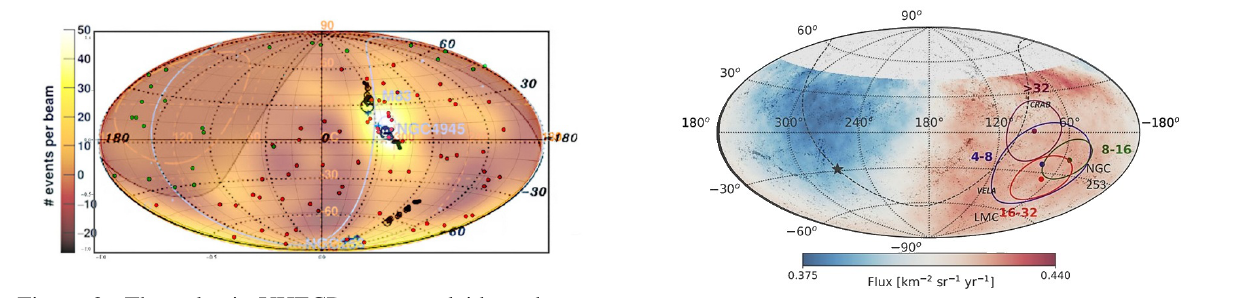
Figure 3: The UHECR dipole clustering in equatorial coordinates. Blue, green, red, and violet points and curves indicate di ff erent energy ranges (4-8, 8-16, 16-32 and > 32). Few suggested galactic or nearby extragalac- tic source candidate are labeled. The main extragalactic source, the star-burst NGC 253 role, is well correlated to the 8 − 16; 16 − 32 EeV anisotropy energy ranges.